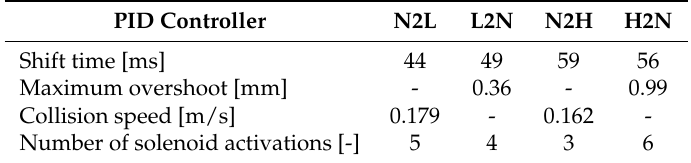
Table 2. Performances of the PID controller at 9 bar supply pressure